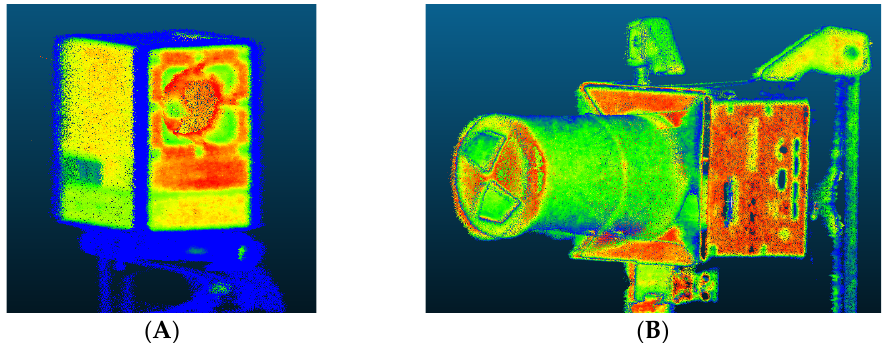
Figure 10. Point clouds generated by the Riegl ® VZ-400, representing the ( A ) Livox ® Mid–40 and the ( B ) Velodyne ® HDL–32E. ( B ) Velodyne ® HDL–32E